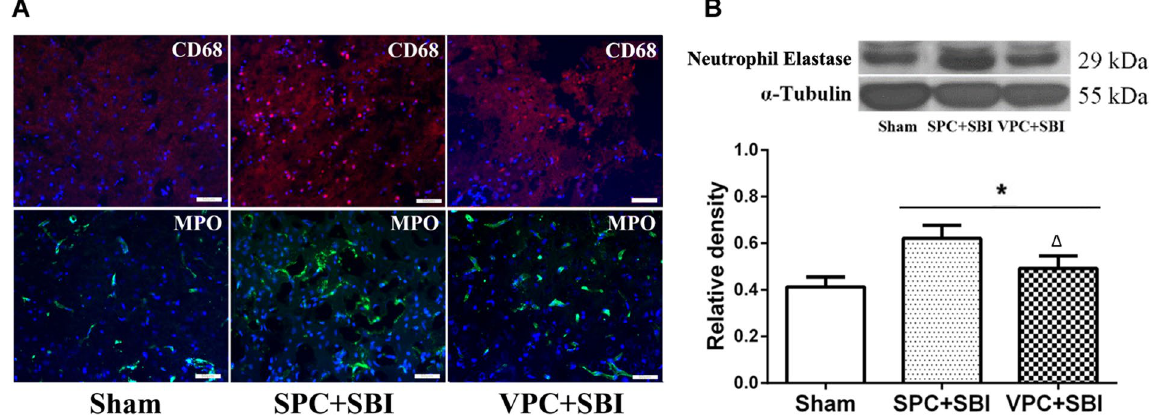
Figure 4. Immunofluorescence staining and western blot showing inflammatory markers in the right frontal peri-resection site in Sham, SPC + SBI and VPC + SBI groups 24 h after SBI. (A) Immunofluorescence staining showed fewer CD68- and MPO-positive cells in VPC + SBI rats compared to SPC + SBI group. n = 2/group. Scale bar = 50 μ m. (B) Western blot quantification showed that neutrophil elastase was reduced in VPC + SBI group compared to SPC + SBI group. * p < 0.05 vs Sham, ∆ p < 0.05 vs SPC + SBI. Data are shown as mean ± SD. n = 6/group. The full length western blot pictures are shown in Supplemental Figure S3.